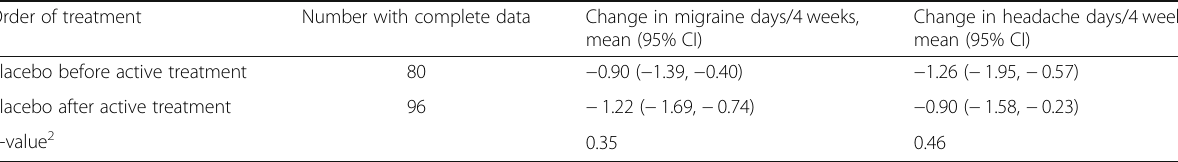
Table 4 Analyses of carry-over effect: effect of active treatment compared to placebo related to treatment sequence ( N = 176) 1 Order of